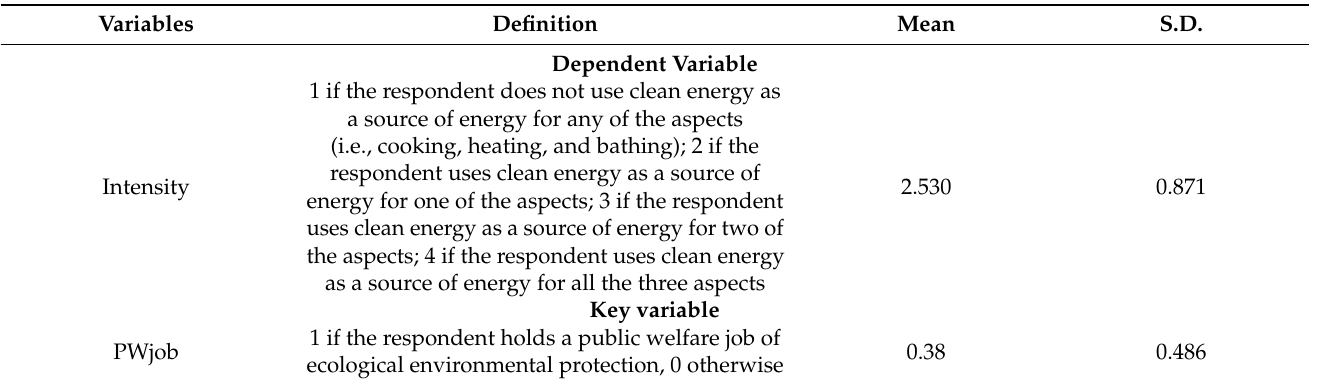
Table 1. Definition and data description of variables in